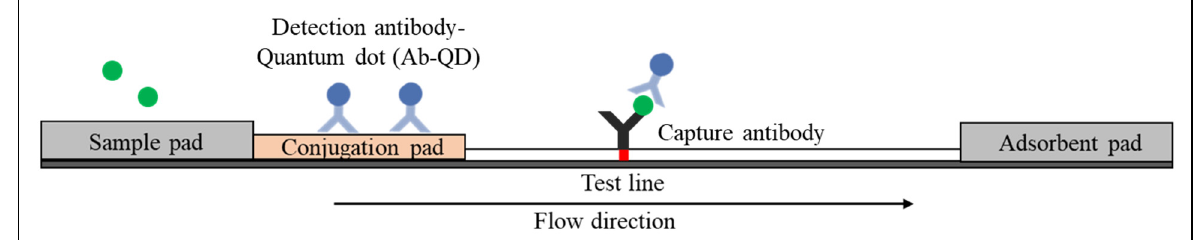
Figure 5. The configuration of the sandwich QD-based LFIA method.